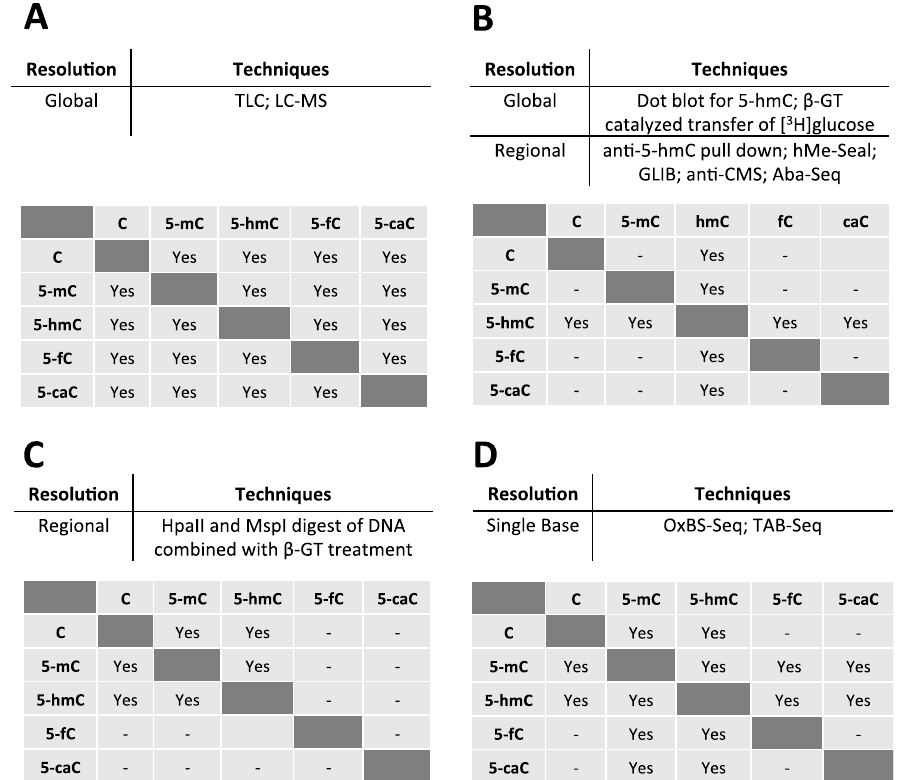
Figure 2. The capacity of various techniques to distinguish modified cytosine species from each other. The ability of a technique to distinguish cytosine species in the top row from those listed in the left column is indicated by a “Yes” entry. ( A ) TLC and HPLC-MS have the capacity to distinguish all modified cytosine species from each other at a global level of resolution. ( B ) At a global level of resolution, dot blots have the capacity to distinguish 5-hmC from all other cytosine species. Affinity purification of 5-hmC, hMe-Seal, GLIB, anti-CMS, and Aba-Seq have the capacity to distinguish 5-hmC from all other cytosine species at the regional level of resolution. ( C ) When combined with β-GT treatment of DNA, HpaII and MspI digestion of DNA has the capacity to distinguish cytosine, 5-mC, and 5-hmC. ( D ) When done in parallel with traditional bisulfite sequencing, oxidative bisulfite sequencing (OxBs) and Tet-assisted bisulfite sequencing (TAB-Seq) can distinguish various modified cytosine species at single base